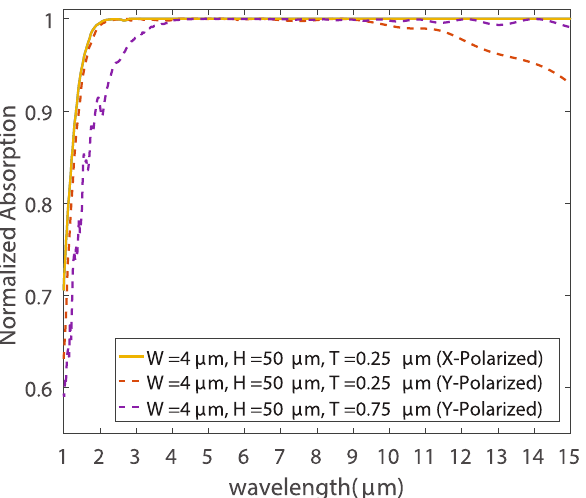
Figure 5. Absorption spectrum for the nanoprisms achieving maximum absorption for x-polarized waves (solid lines) and y-polarized waves (dashed